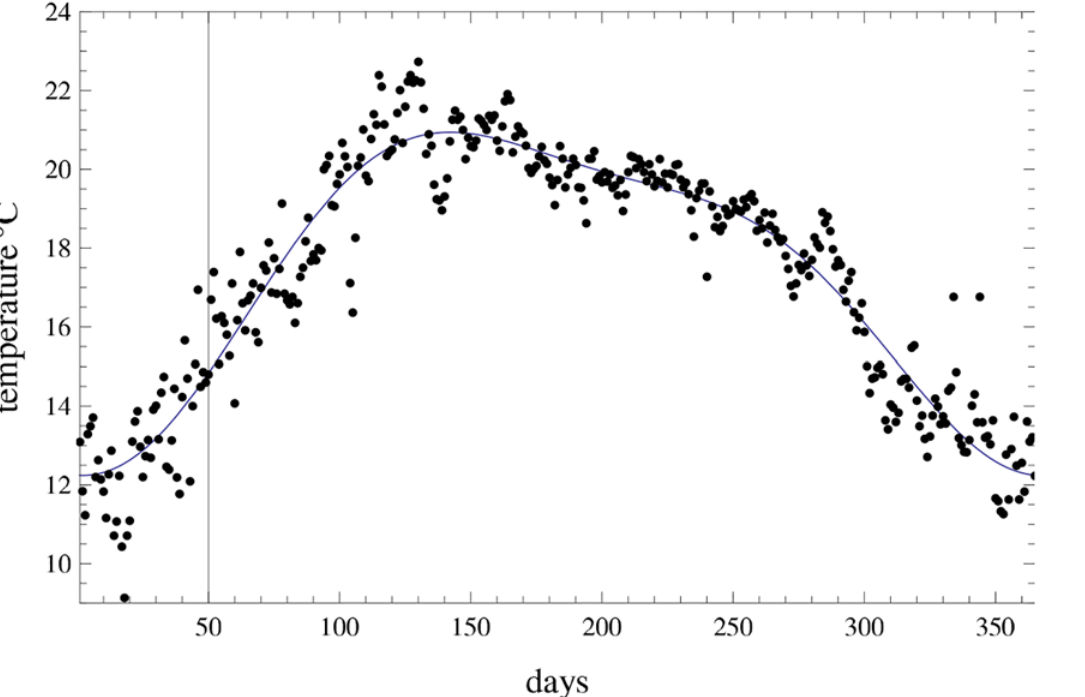
Fig 7. Average daily temperature data in SLP. Daily record from 2003 to